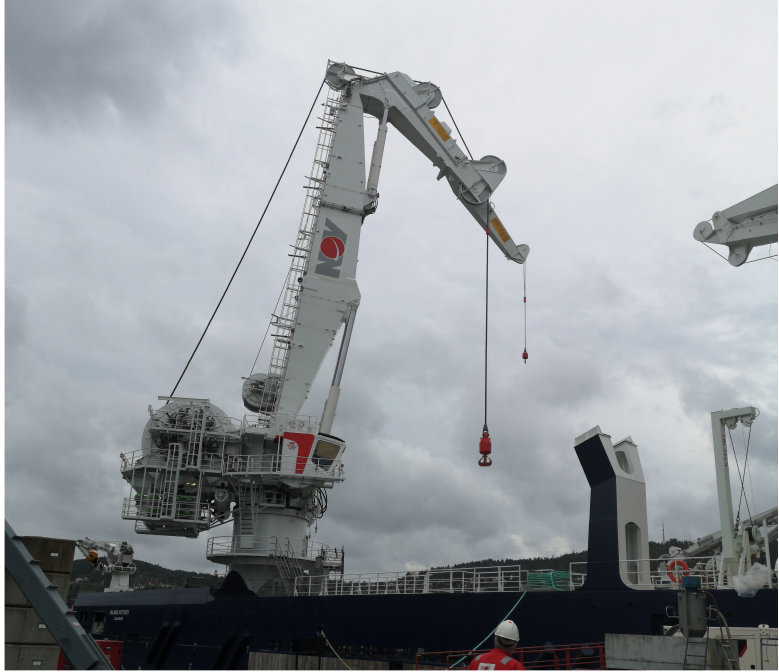
Figure 12. A 250t AHC crane from National Oilwell Varco placed on a